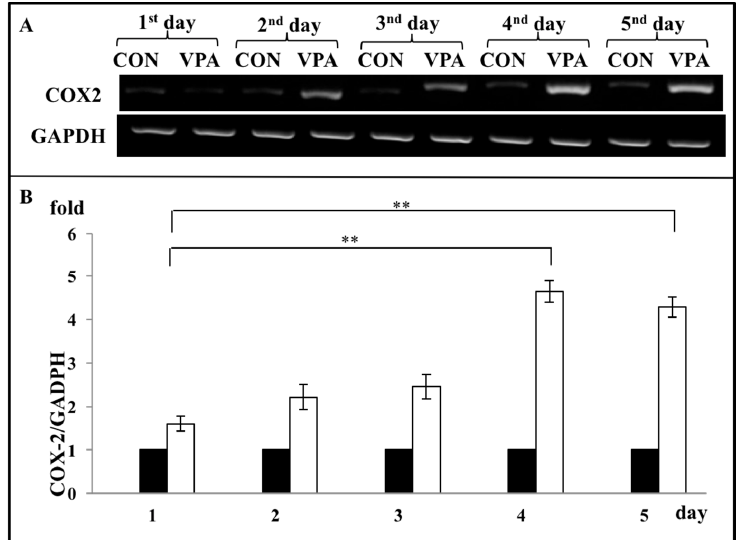
Figure 6. Optimization for VPA treatment on the chondrocytes. Rat growth plate chondrocytes were plated for 5 groups and 60 μ g/mL of VPA were daily treated in each from 1 to 5 days. After treatment, each group’s COX-2 mRNA expression levels were analyzed and compared. ( A ) The upper panel of the gel showed COX-2 mRNA levels in the 4 days and 5 days group significantly higher than the first day group. GADPH served as internal controls. ( B ) Quantitative data of expression levels of COX-2 mRNA in the experiment A. All bars represent the mean ± S.D. The black bars are CON (control, culture medium) and the white bars are VPA (valproic acid, 60 μ g/mL) ( n = 7, ** p < 0.01).